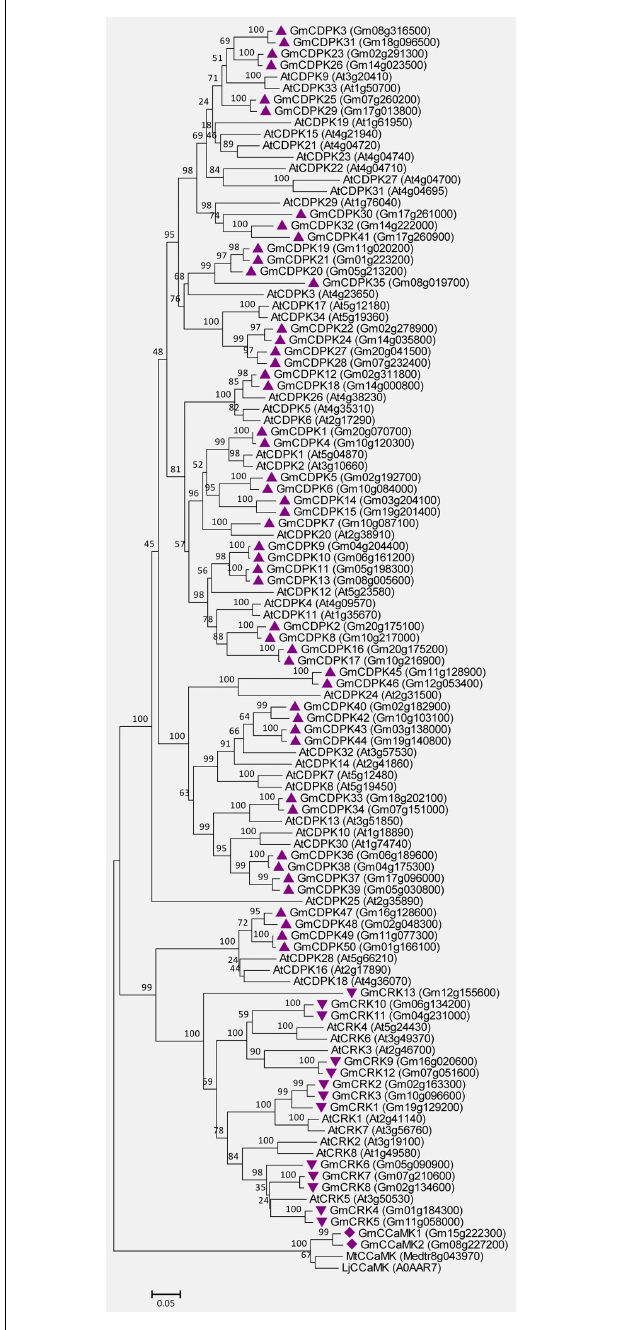
FIGURE 7 | Unrooted phylogenetic tree of the GmCDPK, GmCRK, and GmCCaMK proteins. The alignment for the phylogenetic tree was performed with ClustalW using full-length amino acid sequences. The phylogenetic tree was created with the MEGA6 software and the neighbor-joining method with 1,000 bootstrap replications. All the 50 GmCDPKs are marked with triangles, 13 GmCRKs are marked with inverted triangles, and 2 GmCCaMKs are marked with diamonds, while proteins from Arabidopsis (34 CDPKs and 8 CRKs), and CCaMKs from Medicago truncatula (MtCCaMK) or Lotus japonicus (LjCCaMK) are not marked. Locus name of each gene is shown in brackets. The bar indicates the relative divergence of the sequences examined and bootstrap values are displayed next to the branch.